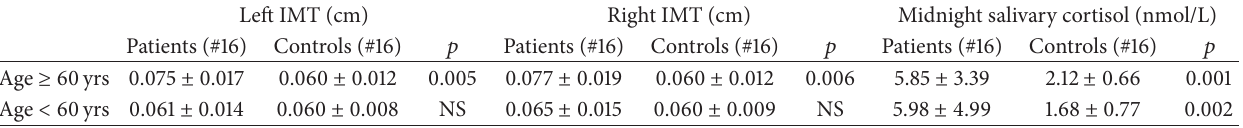
Table 4: Comparison between patients and controls stratified by